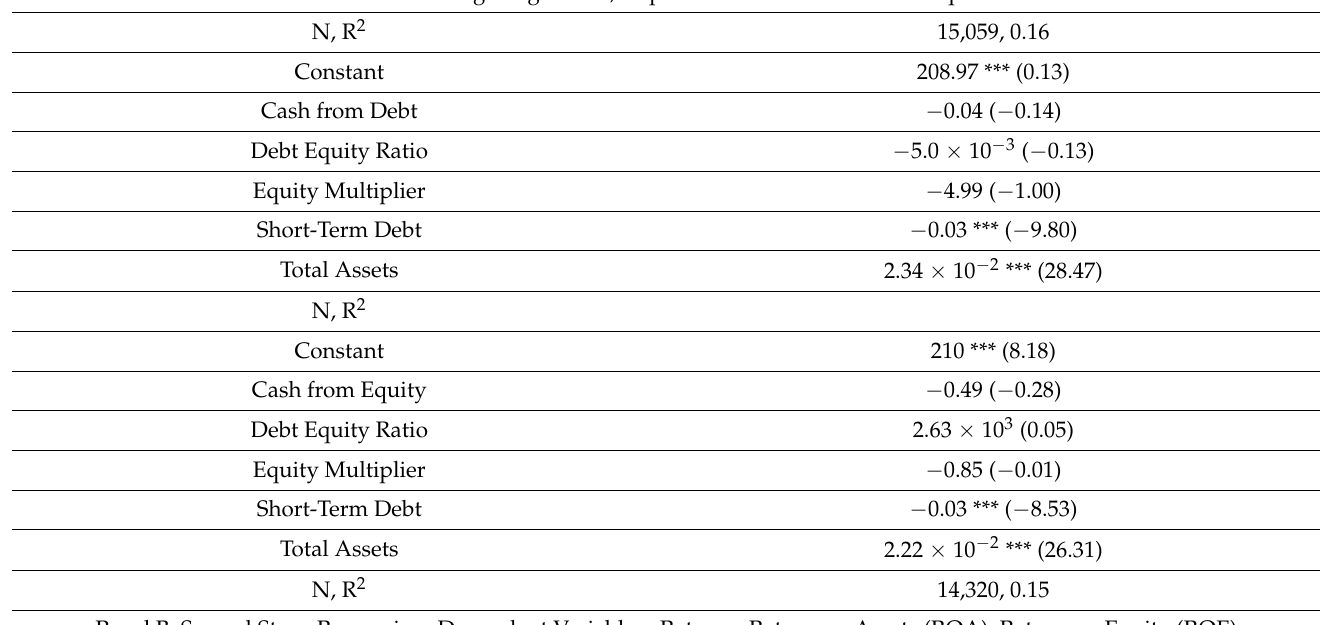
Panel A: First Stage Regression, Dependent Variable = Size of